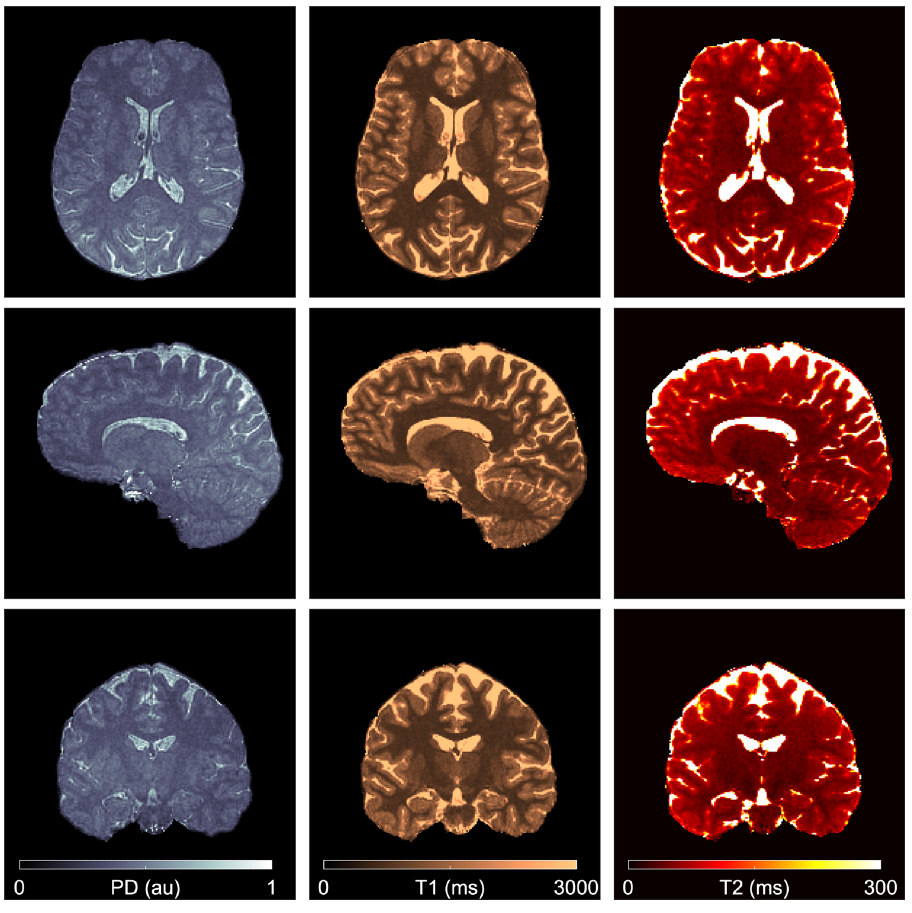
Figure 12. Accelerated mapping. The method presented here achieves submillimeter isotropic resolution multiparametric mapping in under 5 min with efficient reconstruction and neural network parameter inference in under 7